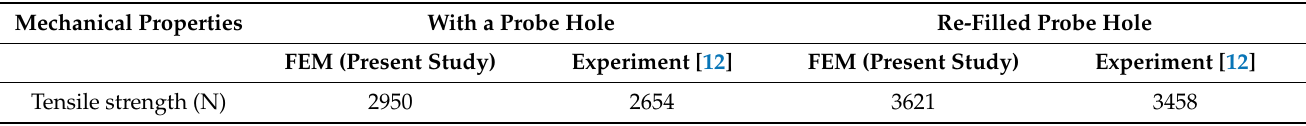
Table 4. The tensile strength for FSSW